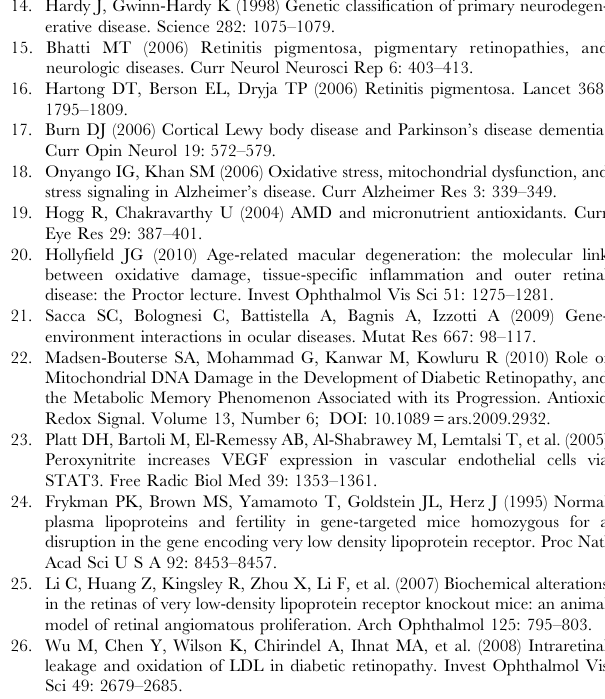
Figure S1 Raw XPS spectra of nanoceria samples. The peaks between 875 and 895 eV belong to the Ce 3d 5/2 while peaks